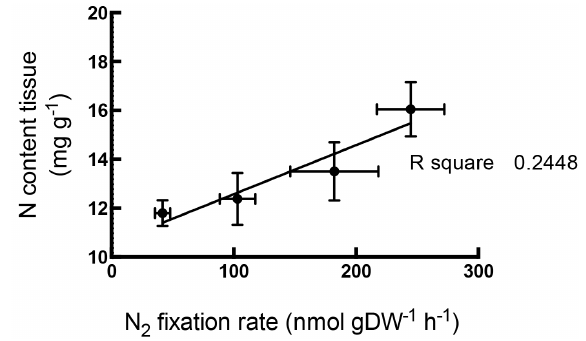
Figure 6. Linear regression of the average N content of Sphagnum , including its microbiome against the average N 2 fixation rates of both